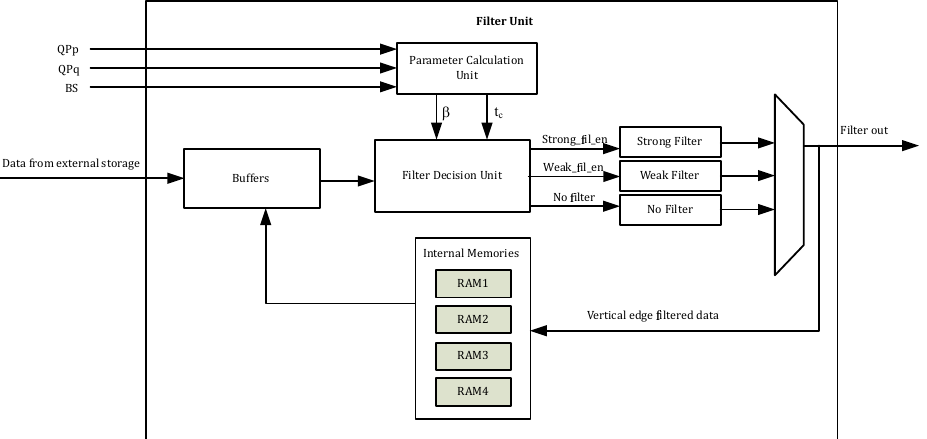
Figure 6. Filter unit of dual-edge deblocking filter architecture.